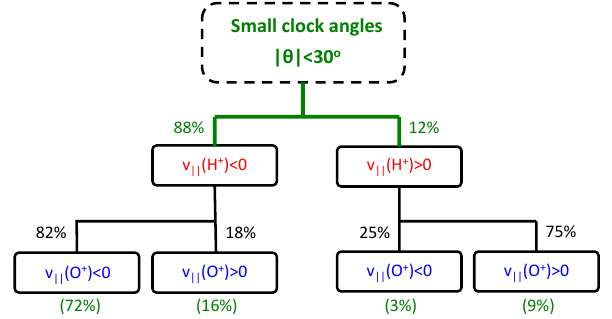
Figure 6. A tree diagram showing how the small clock-angle data are distributed in response to the parallel velocity directions for H + and O + , where a positive parallel velocity corresponds to an equa- torward